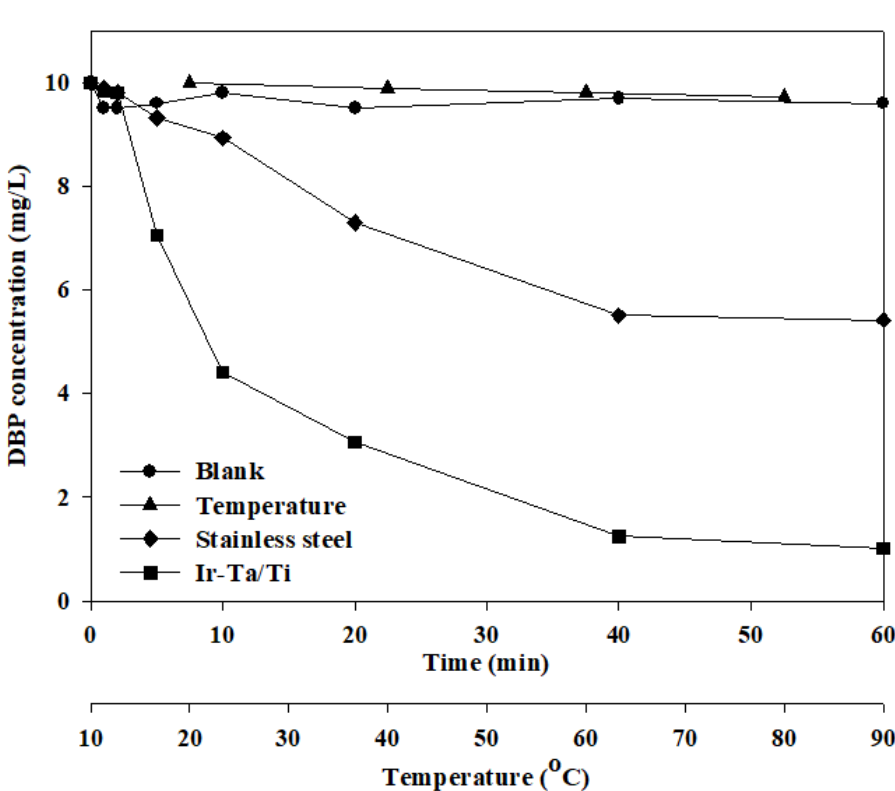
Figure 2. The removal efficiency of different electrodes for DBP degradation.